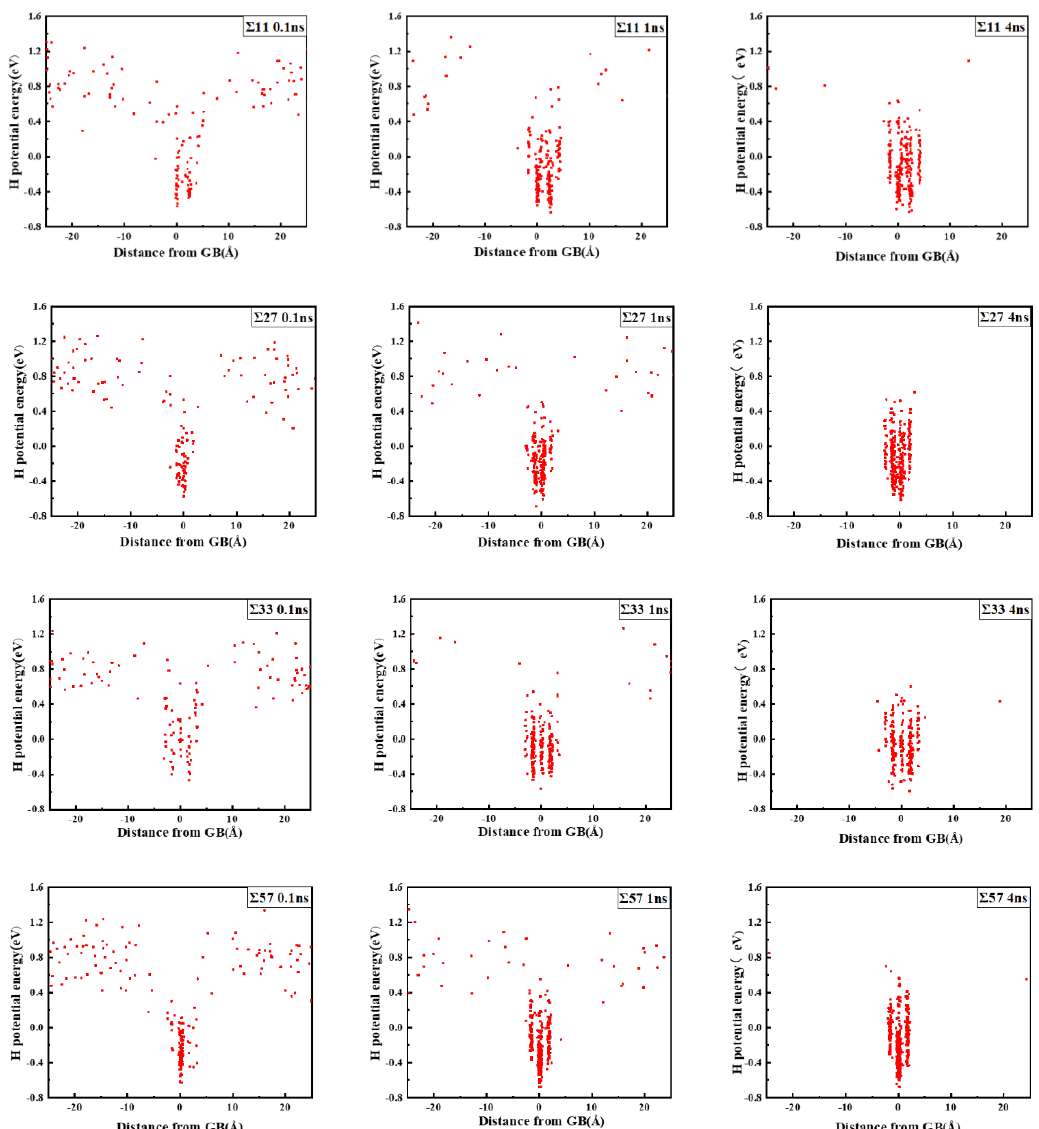
Figure 3. Hydrogen distribution and potential energy in the GBs. The zero value in the X axis indicates the center of the GB plane.